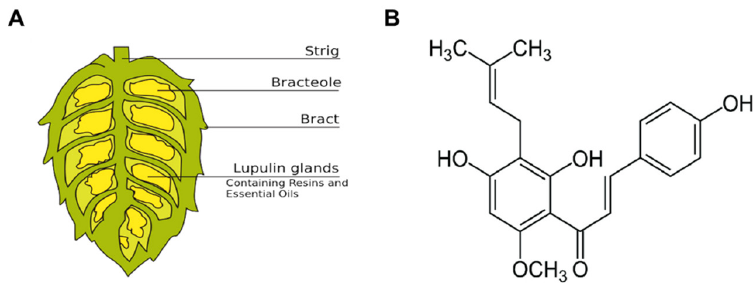
Figure 1. Xanthohumol (XN), a prenylated chalcone isolated from the hop plant. (A) Schematic drawing of a female hop cone that is composed of a central spine: the strig, bracteoles, bracts, and the characteristic lupulin glands that are tiny yellow sacs containing the hop oils. (B) Chemical structure of xanthohumol (3 ′ -[3,3-dimethylallyl]-2 ′ ,4 ′ ,4-trihydroxy-6 ′ -methoxychalcone).